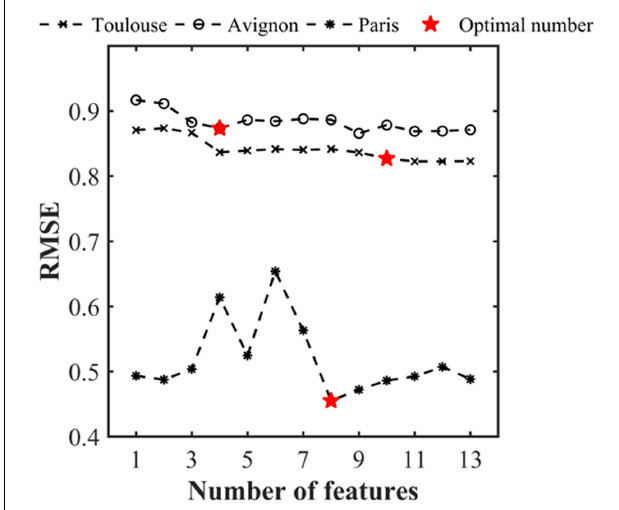
FIGURE 6 | RMSE associated to the estimates of the number of plants per object as a function of the number of features used. The RMSE was evaluated over the test data set for each individual site.